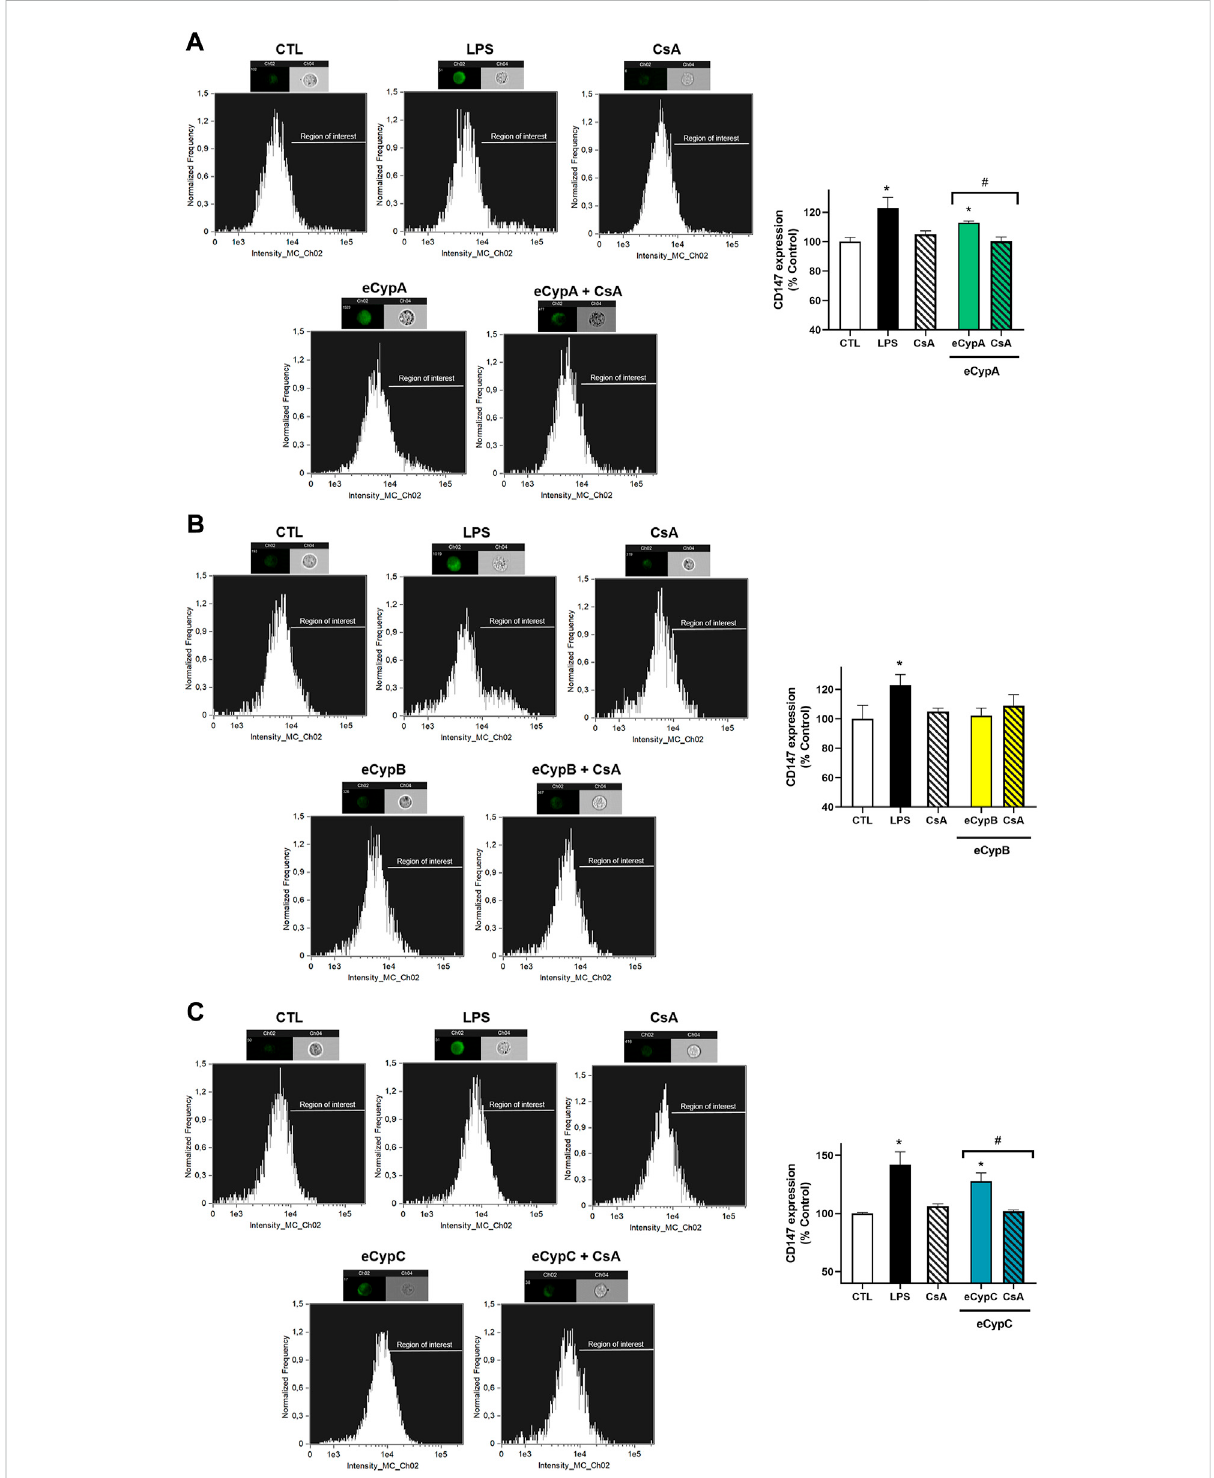
CD147expressionanalysisby fl owcytometryaftereCypstreatment.Resultsof (A) eCypA, (B) eCypB,and (C) eCypC.MS1pancreaticendothelial cells were treated with eCyps A, B and C at 0.5 μ g/ml for 24 h and CD147 receptor expression in cell surface was determined with FITC-CD147 antibody. LPS at 1 μ g/ml was used as pro-in fl ammatory control and pre-treatment with 0.2 μ M CsA was carried out to revert eCyps effects. Upper panels show histograms of a representative replicate and lower panels present the corresponding graph bars. Data are mean ± SEM of three independent replicates, presented as percentage of control cells. Statistical differences were determined by one way ANOVA and Tukey ’ s tests (* p < 0.05, compared to control cells, # p < 0.05, pairwise comparison as